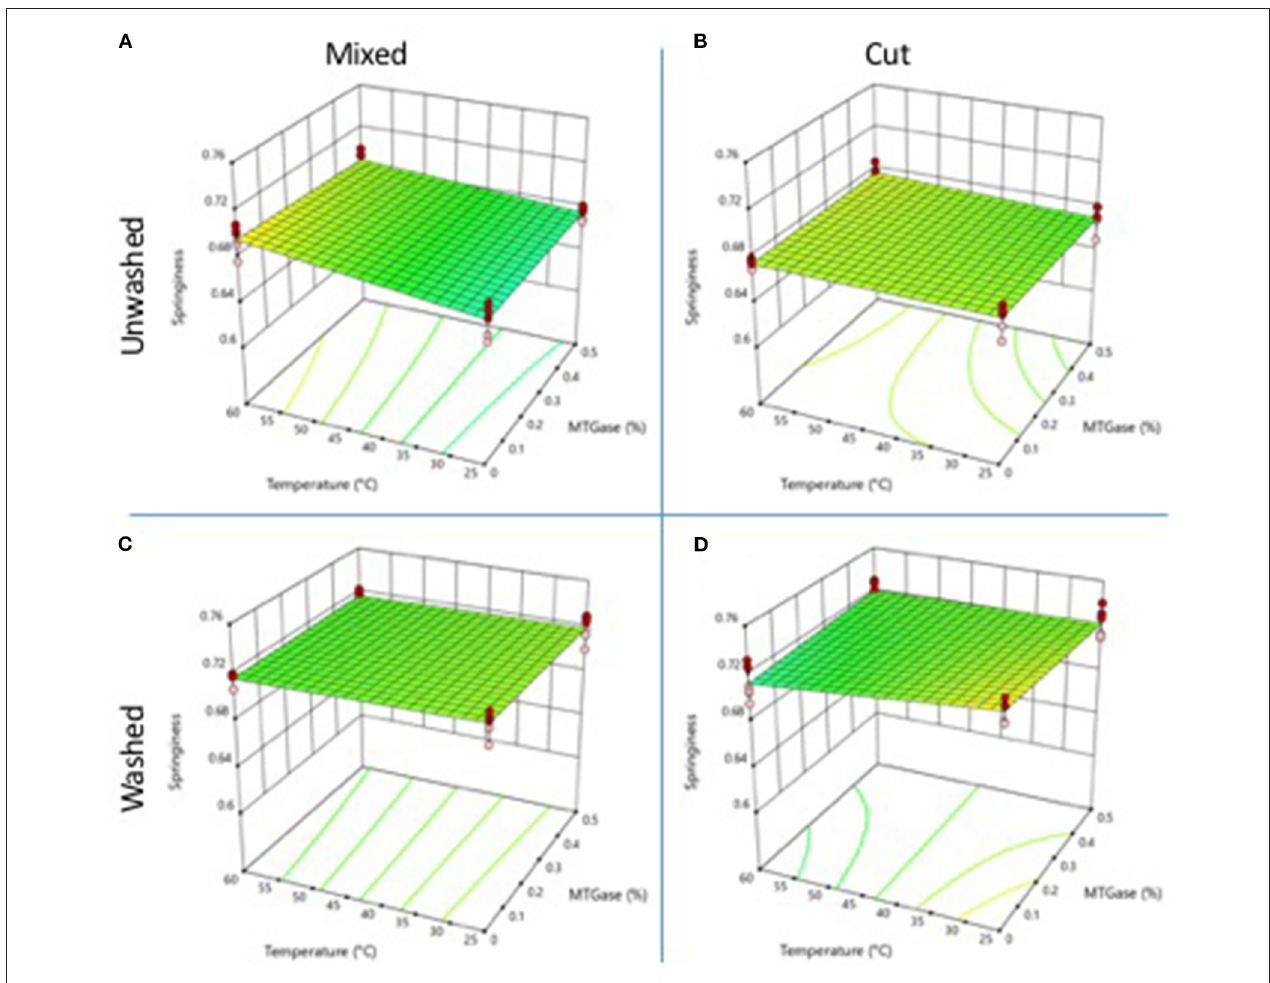
FIGURE 3 | Changes in gel springiness properties as a function of the type and temperature mixing method, washing of the cooked meat, and adding of microbial MTGase. (A) Mixed-unwashed samples, (B) Cut-unwashed samples, (C) Mixed-washed samples, and (D) Cut-washed